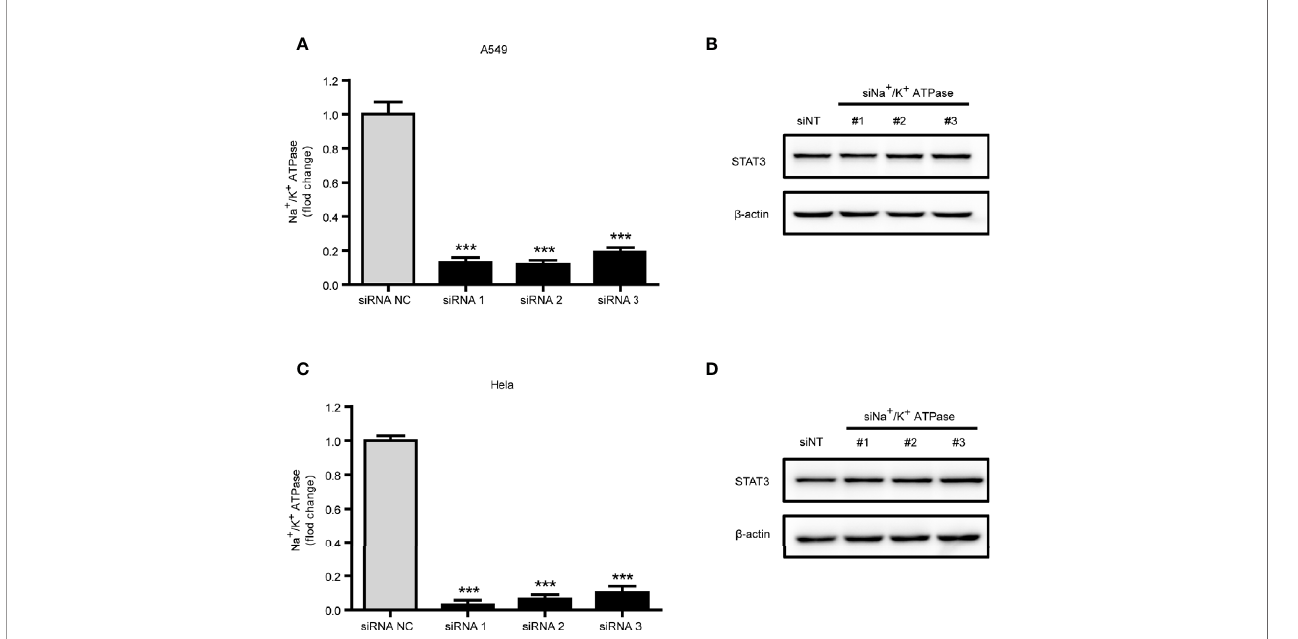
FIGURE 5 | Downregulation of STAT3 by ouabain was independent of Na + /K + -ATPase. (A, C) Real-time qPCR veri fi cation of the Na + /K + -ATPase a 1 subunit in A549 cells or Hela cells transfected with siRNAs speci fi cally targeting the Na + /K + -ATPase a 1 subunit. (B, D) Western blotting analysis of STAT3 in transfected cells from (A) or (C) . *** P < 0.001 versus control group, n =